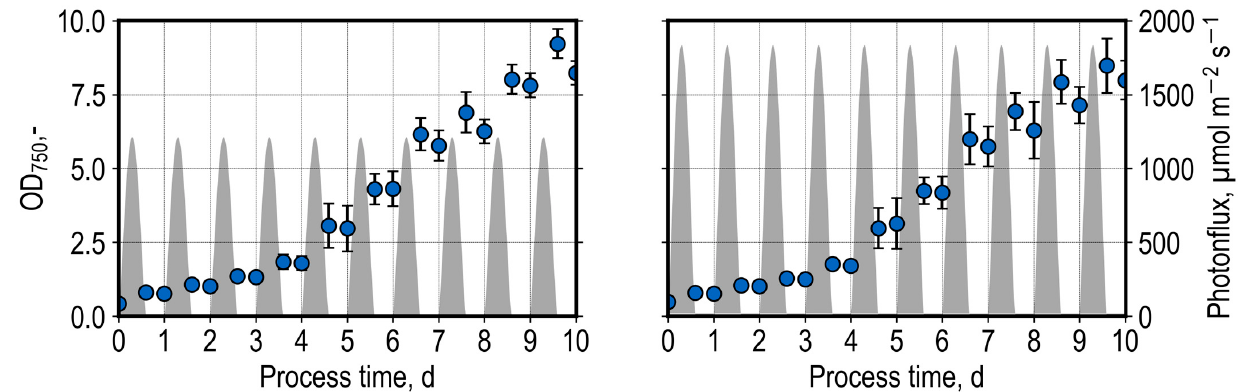
50 * The incident light intensity was not published. ** The CDW concentration was estimated on the basis of the measured OD 750 , applying a linear correlation factor of 0.44 g L − 1 . *** Nannochloropsis sp. 3.2. Photoautotrophic Cultivations of M. salina in Miniaturized Stirred-Tank PBRs with Day and Night Cycles Outdoor cultivations of microalgae are subject to variations in temperature and inci- dent light intensities arising from natural day and night cycles. For this reason, day and night cycles of incident light intensities and temperatures configured to imitate typical Mediterranean climate conditions (repeated summer day in Almeria, Spain, recorded by